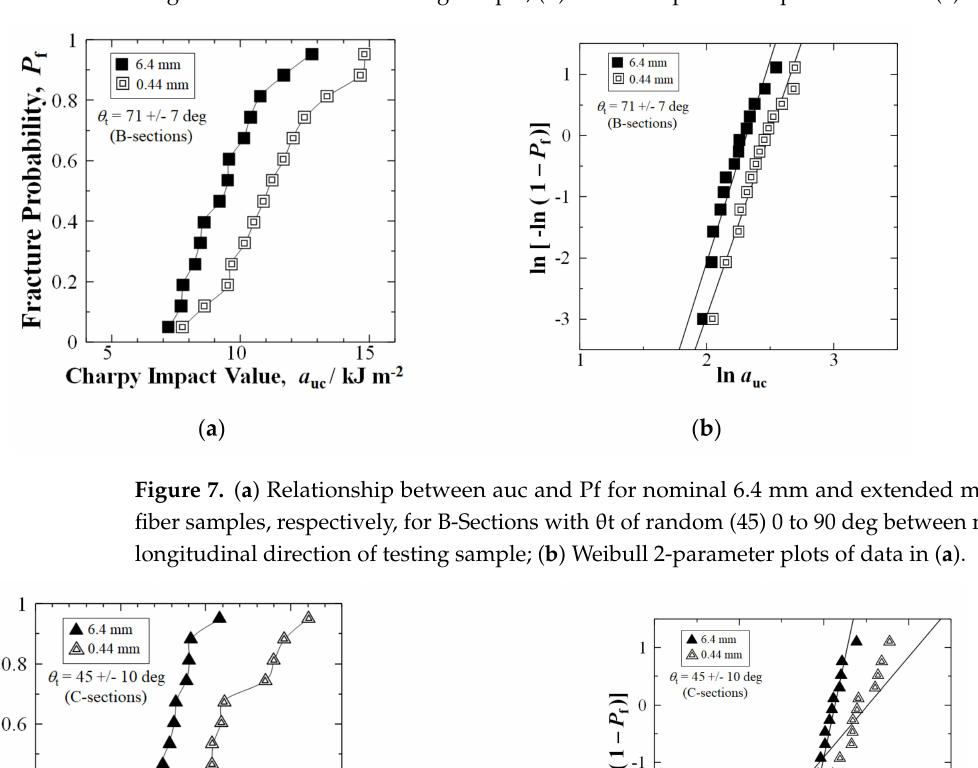
Figure 6. ( a ) Relationship between auc and Pf for nominal 6.4 mm and extended mixed 0.44 mm fiber samples, respectively, for A-Sections with θ t of random (45) 0 to 90 deg between mold flow and longitudinal direction of testing sample; ( b ) Weibull 2-parameter plots of data in ( a ).